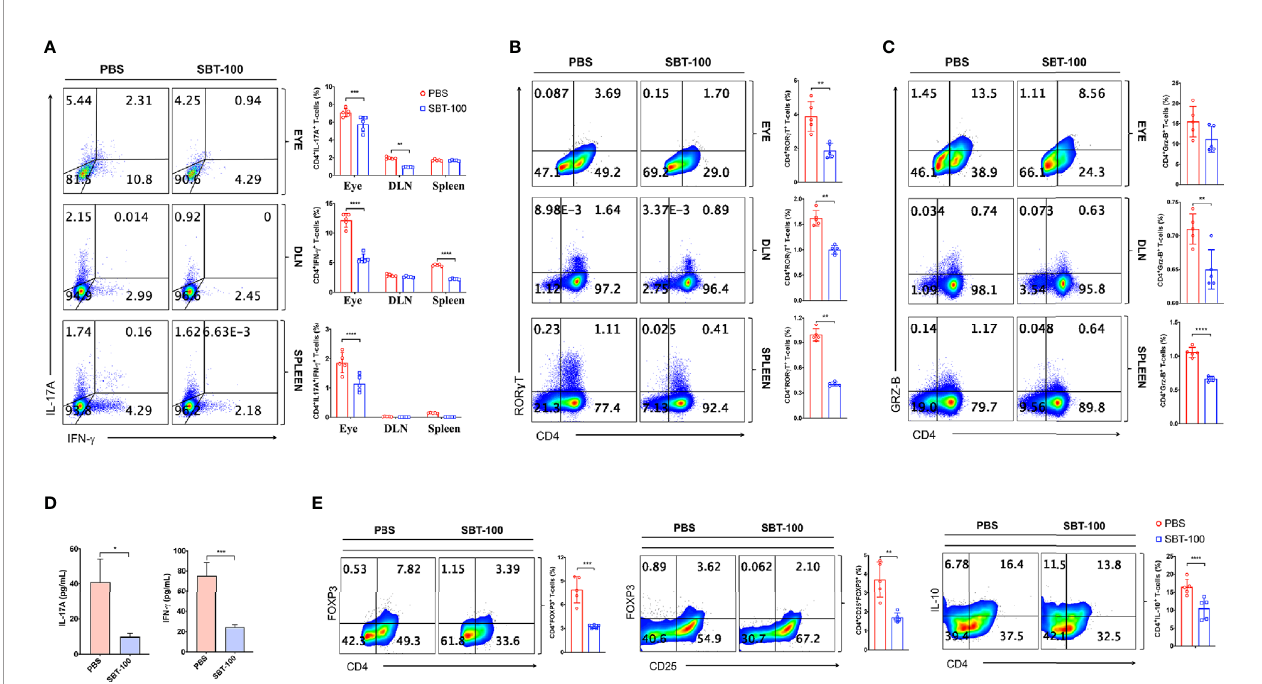
FIGURE 3 | SBT-100 inhibits the differentiation and expansion of Th17 cells during EAU. C57BL/6J mice were immunized with IRBP 651-670 in CFA and treated with PBS or SBT-100. (A) Percentage of Th1 or Th17 cells in the retina, DLN, or spleen, and Th1 or Th17 cells was determined by the intracellular cytokine staining. Quadrants indicate percentage of CD4 + T cells expressing IFN- g or IL-17. (B) Percentage of CD4 + T cells expressing ROR- g T (B) or Granzyme B (C) in the retina, DLN, or spleen. (D) CD4 + T cells from the LN and spleen of EAU mice treated with PBS or SBT-100 were restimulated in vitro with IRBP 651-670 peptide and IL-17A and IFN- g secreted in Day 3 culture supernatant was detected by ELISA. (E) Cells from the spleen of the EAU mice treated with PBS or SBT-100 were analyzed by the intracellular cytokine staining. Quadrants indicate percentage of CD4 + T cells expressing Foxp3, CD25, and/or IL-10. Data represent at least three independent experiments and presented as mean ± SEM. (* p < 0.05; ** p < 0.01; *** p < 0.001; **** p <